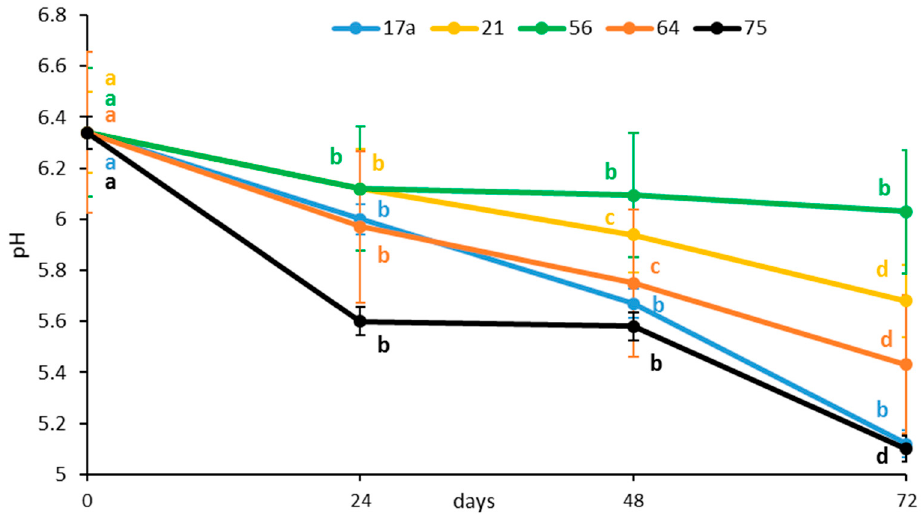
Figure 1. Influence of lactic acid fermentation with di ff erent LAB strains on pH of the brine solution of African nightshade ( Solanum retroflexum ) leaves. Each value represents the mean value of three replicate samples. Means followed by the same letter within a series are not significantly different ( p < 0.05).